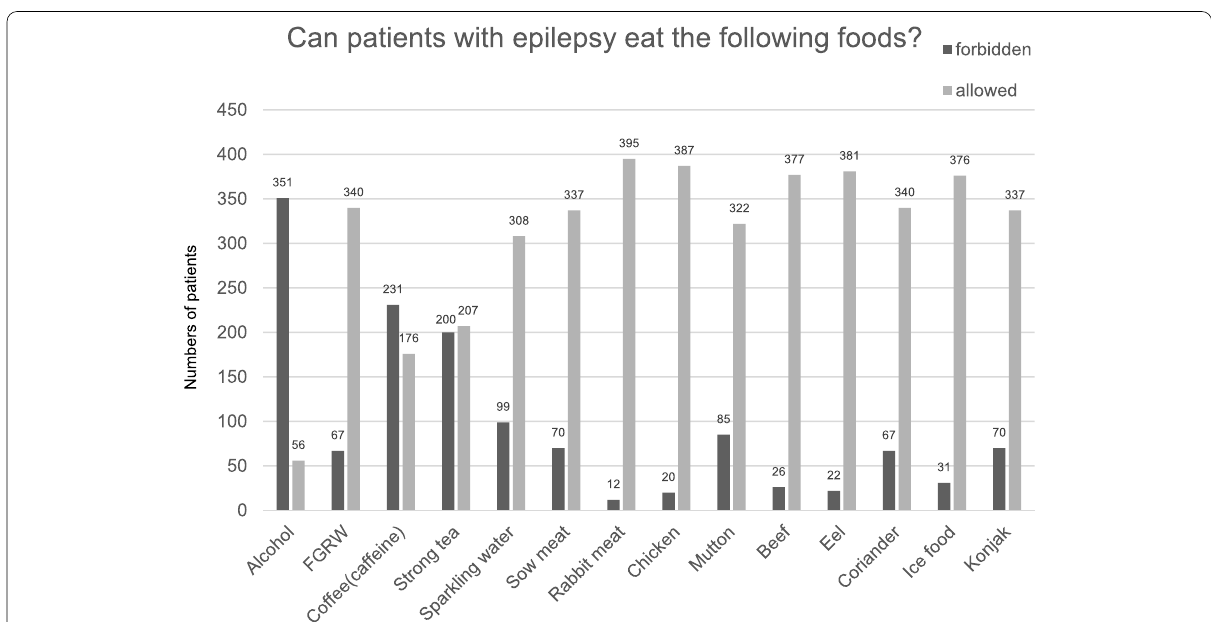
Fig. 2 Awareness about dietamong patients with epilepsy. Abbreviations: FGRW fermented glutinous rice